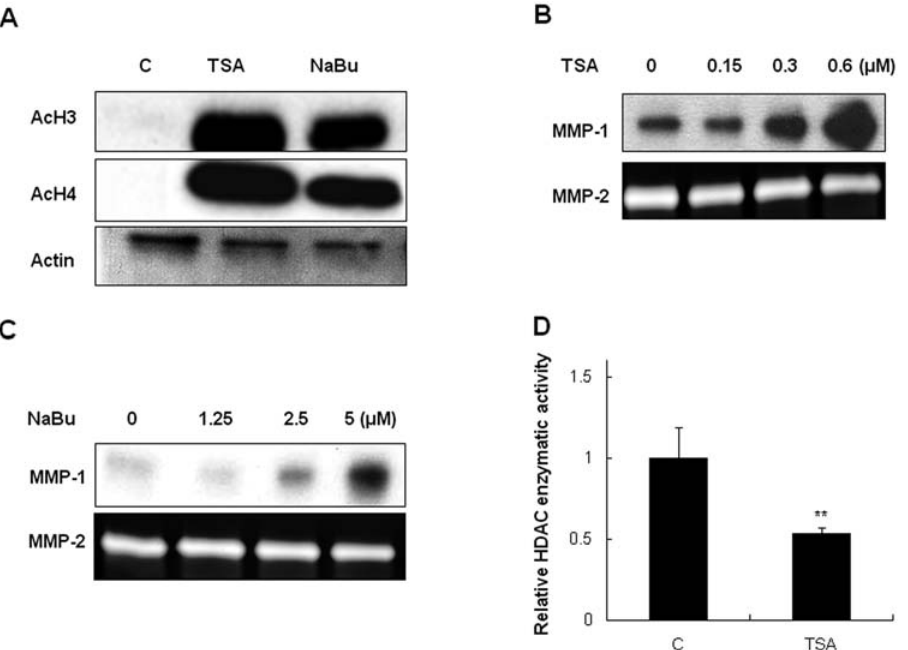
Figure 2. HDAC inhibitors induced MMP-1 expression. A, Western blot of cell lysates of HDFs after 6 h incubation with HDAC inhibitors, TSA and NaBu. Acetyl-H3 and acetyl-H4 were assessed using antibodies against acetyl-H3 and acetyl-H4. B, C, The amounts of MMP-1 and MMP-2 proteins released into culture media from HDFs were analyzed 24 h post-treatment with TSA or NaBu by western blotting (MMP-1) or zymography (MMP-2). D, Total cellular HDAC enzymatic activity was measured using a HDAC assay kit in untreated control HDFs or in HDFs treated with TSA for 6 h. Values represent the mean 6 SEM of data from three independent experiments. **P , 0.01 vs. control.